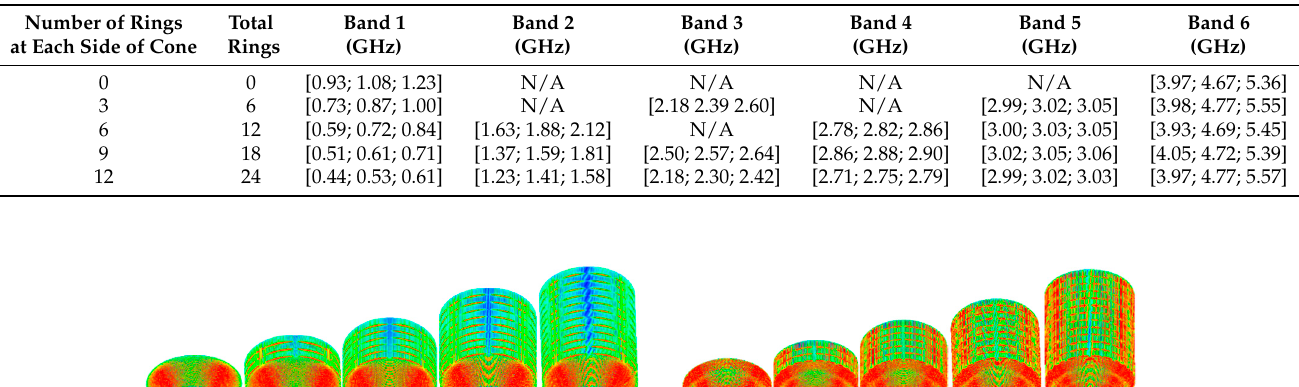
Table 1. The starting, middle and ending frequencies of bands in frequency less than 6 GHz.